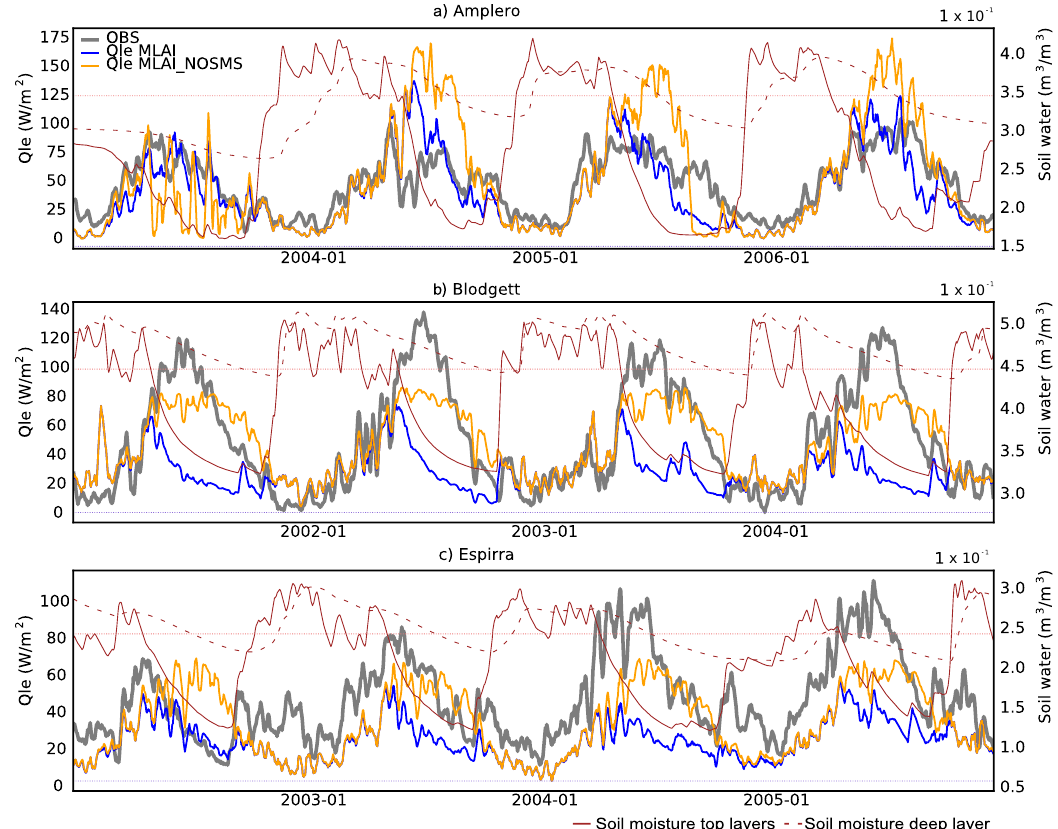
Figure 2. Latent heat flux (Qle) and soil moisture in Amplero ( a ), Blodgett ( b ) and Espirra ( c ). For the Qle (left axis), the observations are in grey and the simulations from MLAI in blue and from MLAI_NOSM in orange. The soil moisture (right axis) for MLAI simulation is shown for the top 3 layers (red solid) and deep layers (red dashed). The light dotted red and blue lines represent soil moisture at field capacity and the wilting point,